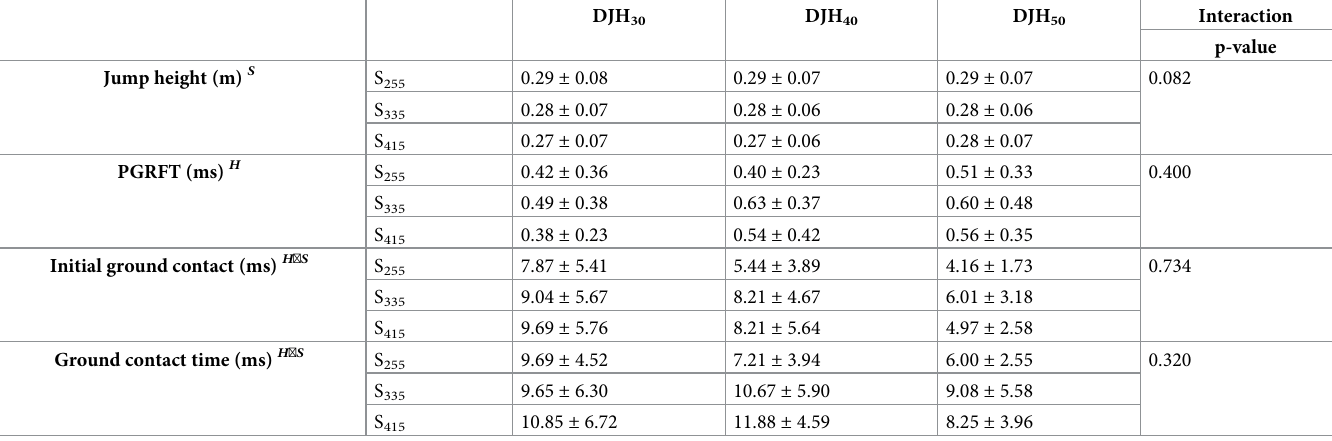
Table 2. The jump height and side-to-side asymmetries of leg kinetics: Mean (SD) with the different shoe weights during DJs from 3